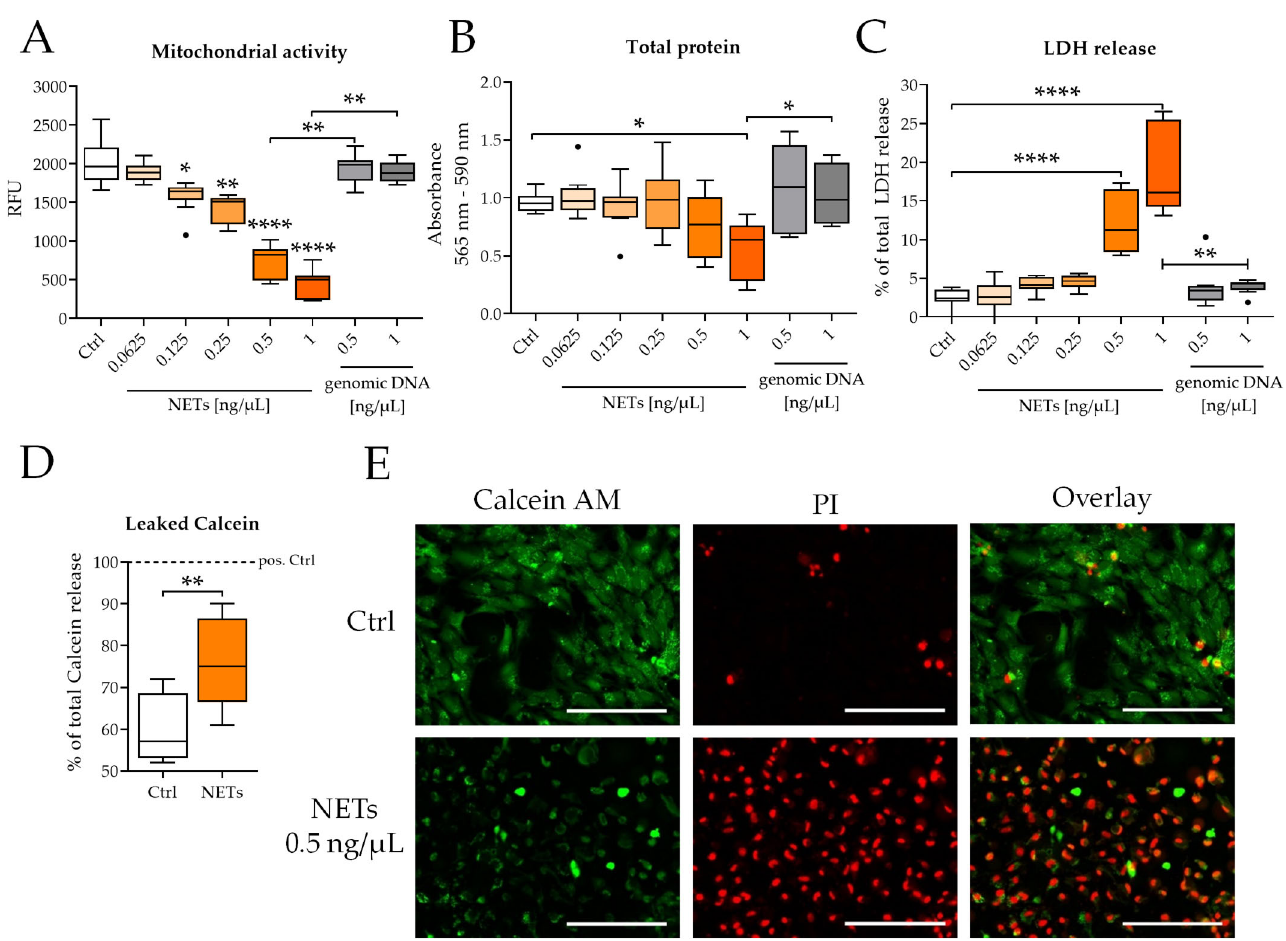
Figure 1. NETs are toxic to SCP-1 cells. SCP-1 cells were incubated with different concentrations of NETs for 48 h. ( A ) Mitochondrial activity was determined by Resazurin conversion. ( B ) Total protein content was determined by SRB staining. ( C ) Percental LDH release as a marker for cell death. ( D ) % of total Calcein released into the supernatant after NETs (0.5 ng/µL) treatment. Mann–Whitney U-test. ( E ) Live (Calcein-AM)/Dead (PI) staining of SCP-1 cells after 22 h. Scale bar 200 µm. N = 3, n = 3. * p < 0.05, ** p < 0.01, **** p < 0.0001 as determined by the Kruskal–Wallis test.